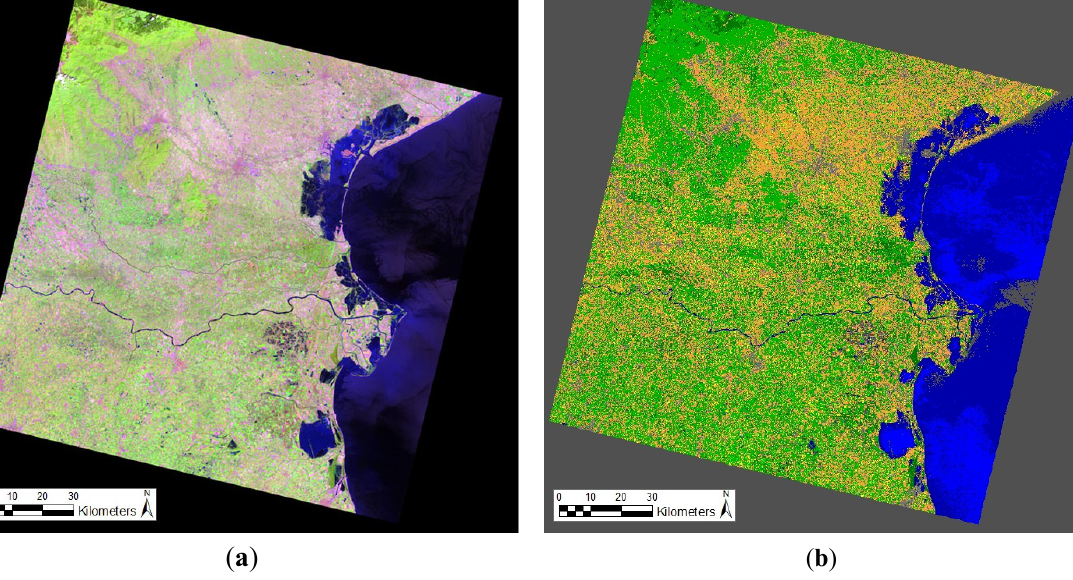
Figure 1. ( a ) False-color (R = MIR band, G = NIR band, B = Green band) IRS-P6 LISS-3 image of Northern Italy (11°53 ′ E, 45°8 ′ N). Spatial resolution: 23.5 m. Acquisition time: 2006 at 10:15:05.83. Orbit: 13 786. Frame: 37. Orthorectified and